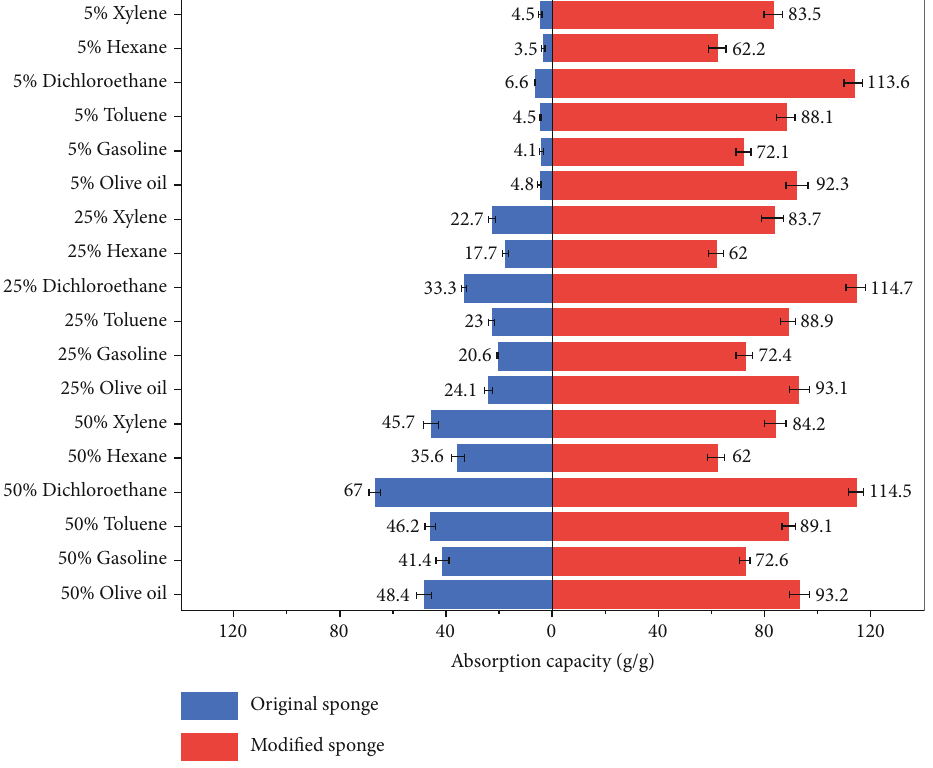
Figure 8: The absorption capacity of the sponge in the oil/water binary system before and after modi fi cation. Table 1: Selectivity of the modi fi ed